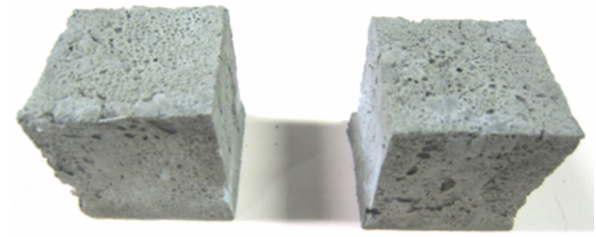
Figure 5. Aerated slurry